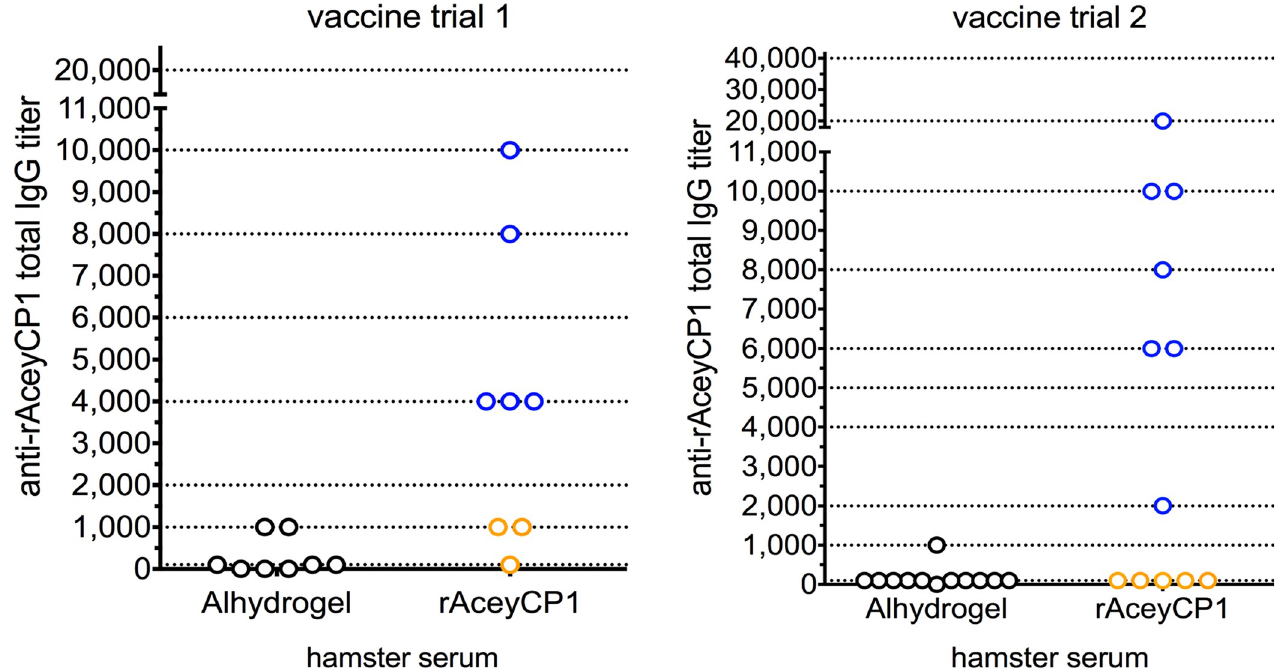
Fig 5. rAceyCP1 serum IgG titers in rAceyCP1/Alhydrogel and Alhydrogel control vaccinates. Blue dots indicate rAceyCP1 serum IgG responders (IgG titers above background levels found in Alhydrogel controls). Orange dots indicate rAceyCP1 serum IgG nonresponders. Dotted lines are indicated at the inverses of each serum dilution